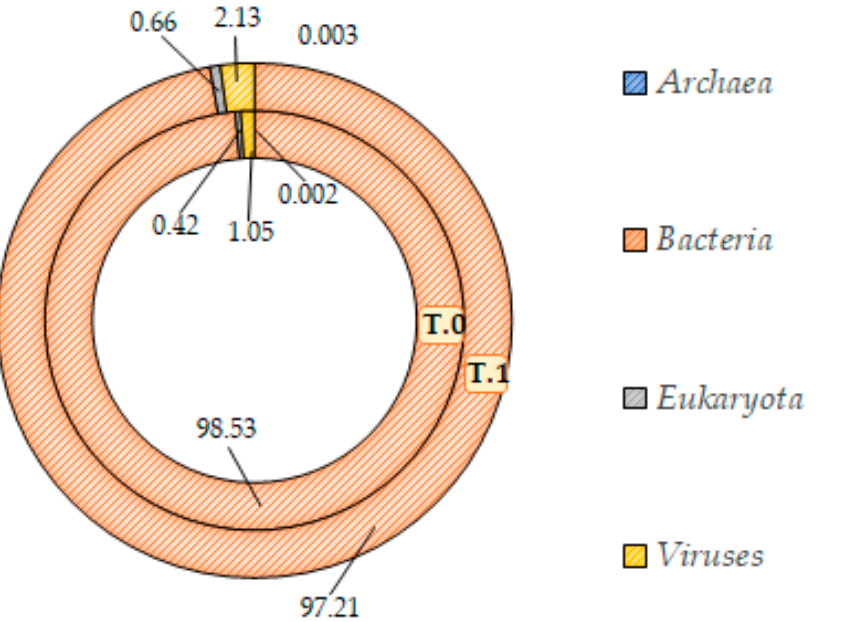
Figure 9. The percentage abundance of principal domains in T.0 (inner ring) and T.1 (outer ring) microbiota.